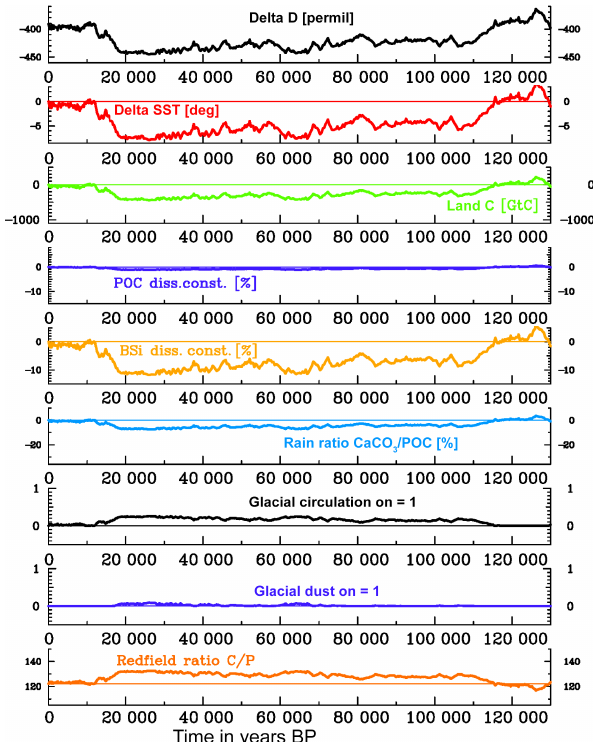
Figure 8. Resulting parameter variations in the past climatic cycle for the rank 6 solution of the linear response